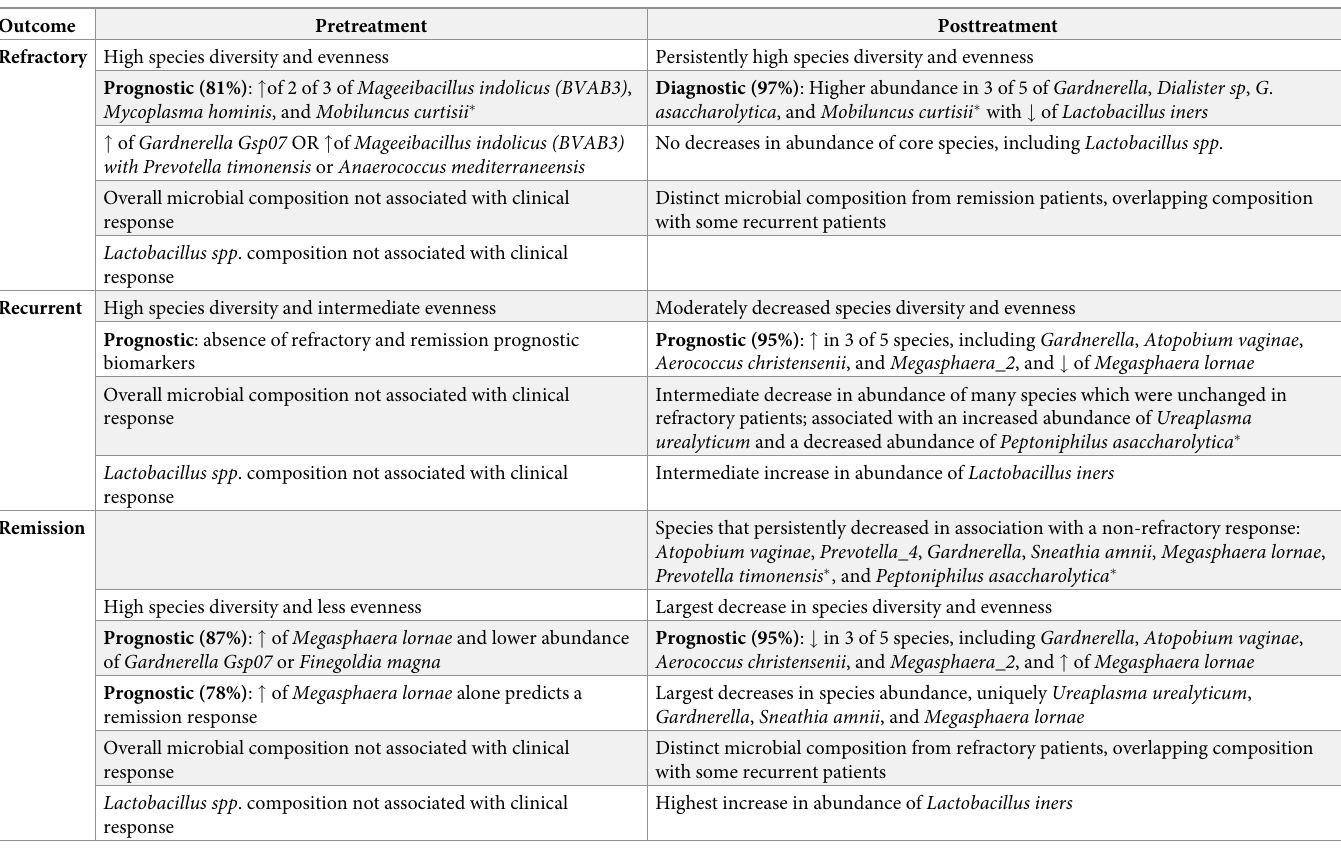
Table 2. Summary of major